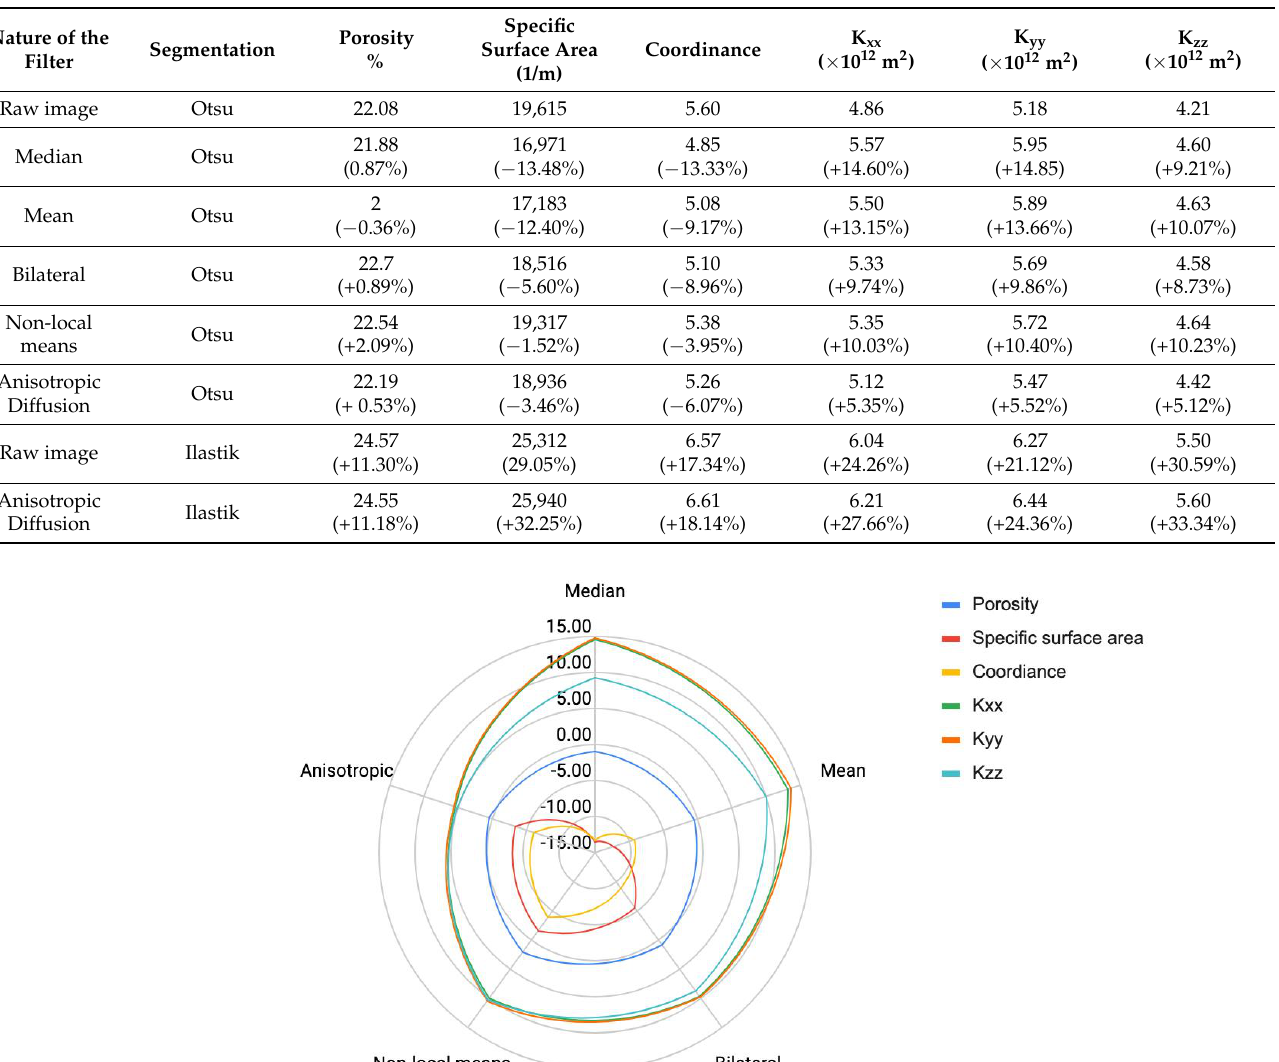
Figure 1. Impact of filtering and segmentation on effective properties. The different filtered 3D images segmented using Otsu are normalized with the Ilastik segmentation.